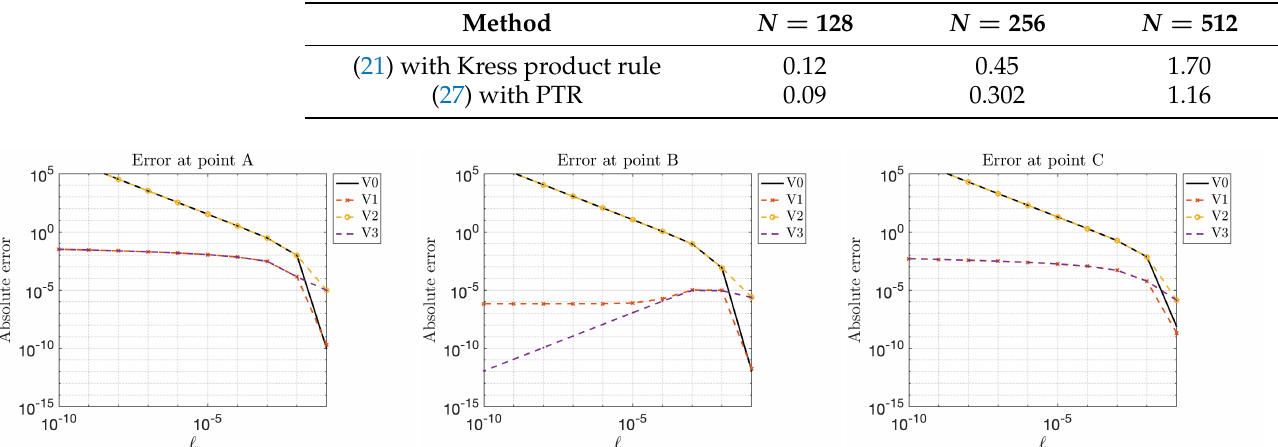
( 1 ) | ) with ( 15 | x ∗ − x H 0 0 4